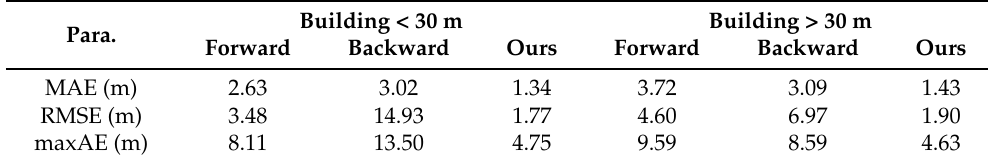
Table 4. The comparison of accuracy statistic of building height. Para.